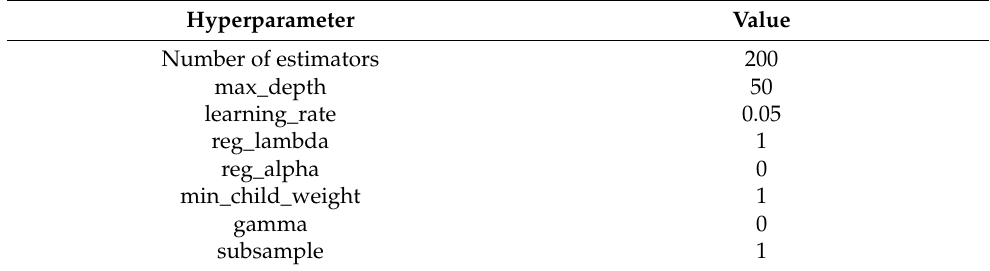
Table 1. Optimal hyperparameter for XGBoost in this paper.